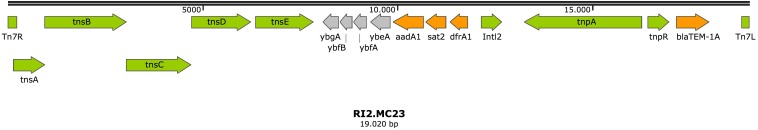
Resistance island RI2.MC23 in isolate MC23. Arrows represent predicted ORFs and the direction of the arrow represents the direction of transcription. Resistance genes are shown by orange arrows and transposon-related genes, recombinases, and insertion sequences are indicated by green arrows. Other genes are indicated by gray arrows. Hypothetical proteins are not shown.